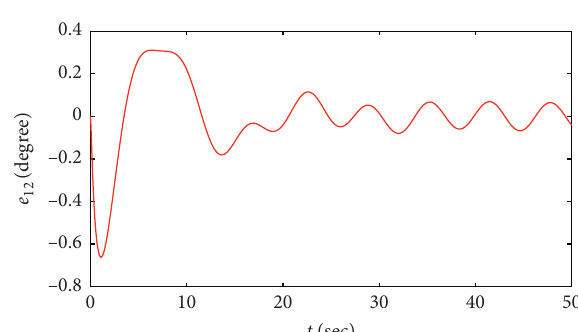
Figure 5: The tracking control error of the swing angle of hanging load θ .